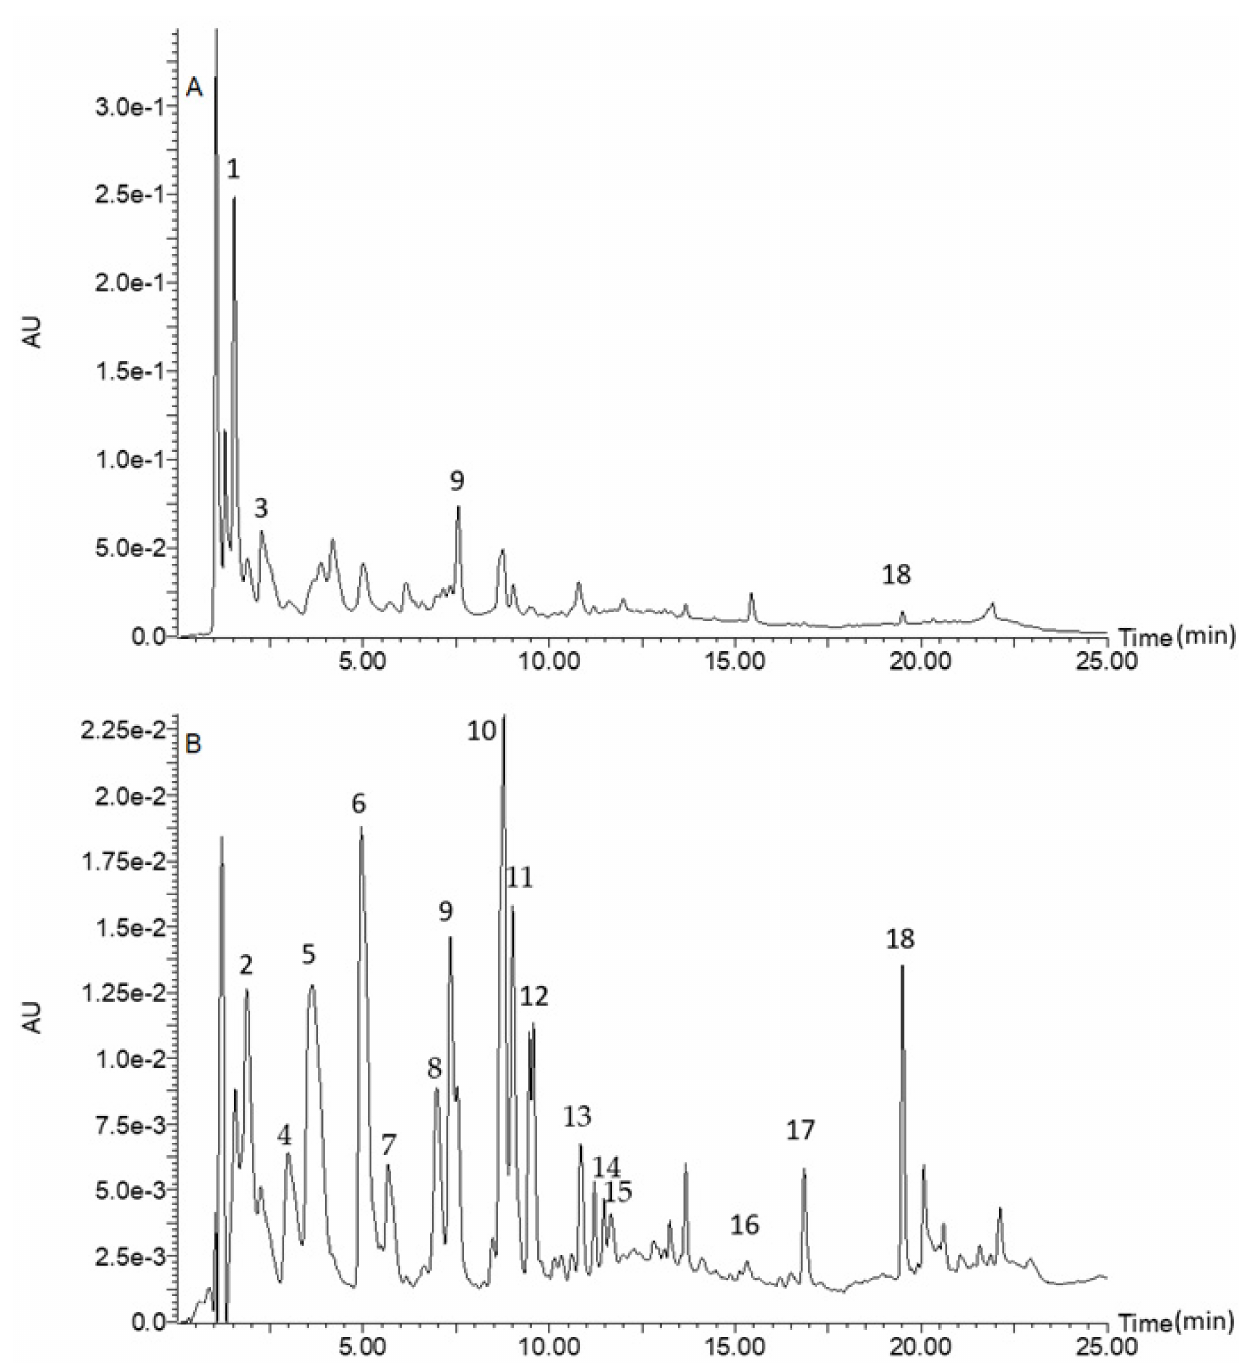
Figure 4. Liquid chromatogram for cooked rice–cowpea blend in sorghum leaves extract at 280 nm ( A ) and 350 nm ( B